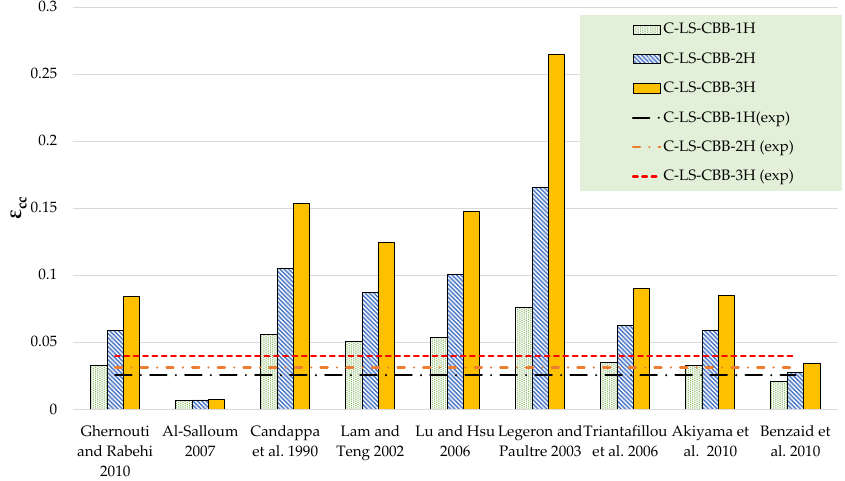
Figure 13. Comparison of strain for Type-1 group [47–55].